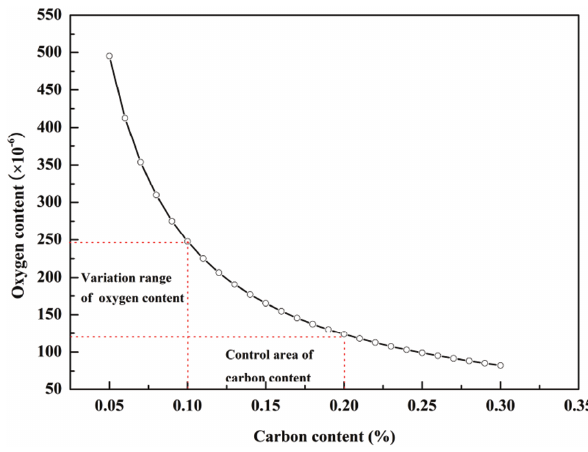
Figure 3: Relation between endpoint carbon content and oxygen